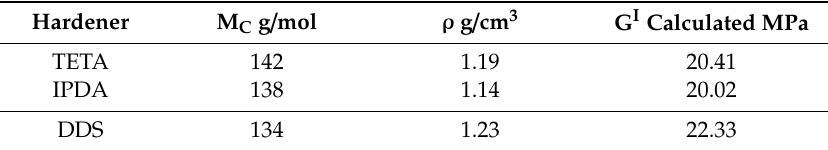
Table 3. Calculated values obtained by the Equations (1) and (2).